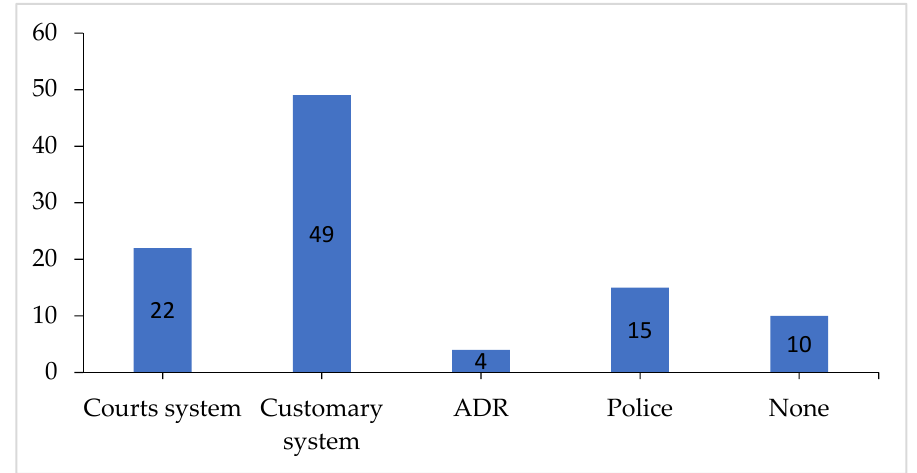
Figure 7. Land disputes resolution mechanism employed by disputants (source: Field survey, 2018).